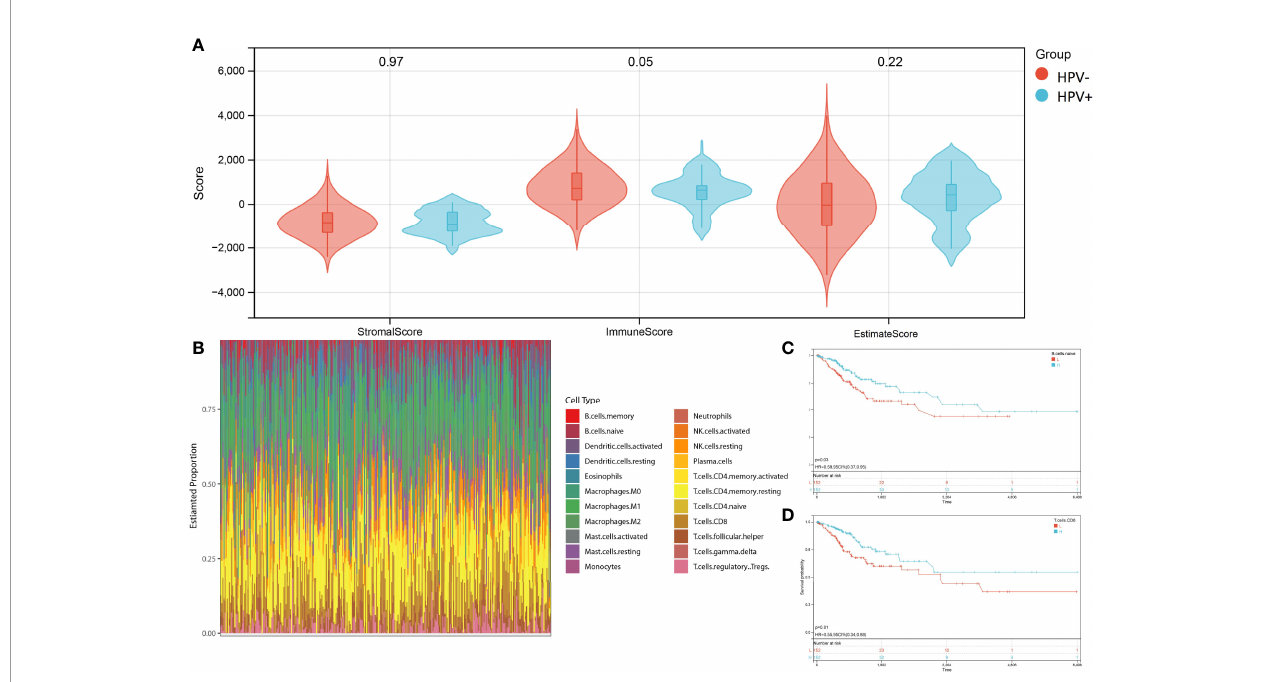
FIGURE 3 | Character of immune in fi ltration. (A) Stromal score, Immune Score and Estimate Score of HPV+ AND HPV- group. (B) Bar charts of 22 immune cell proportions in CESC TCGA RNA-seq. (C) KM curves of different expression Naive B cell. (D) KM curves of different expression CD8+ T